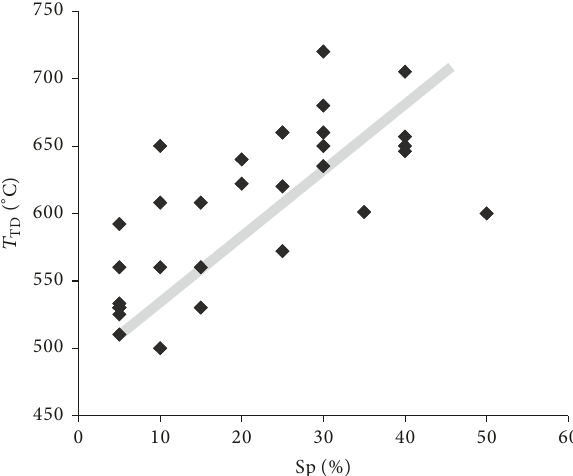
Figure 9: The diagram showing the relationship between the volume proportion of solid phases (Sp) and the total dissolution temperature of crystals within CIs ( 𝑇 ). The grey line shows the trend that 𝑇 tends to increase as the volume proportion of the solid phases in the CIs TD TD increases.